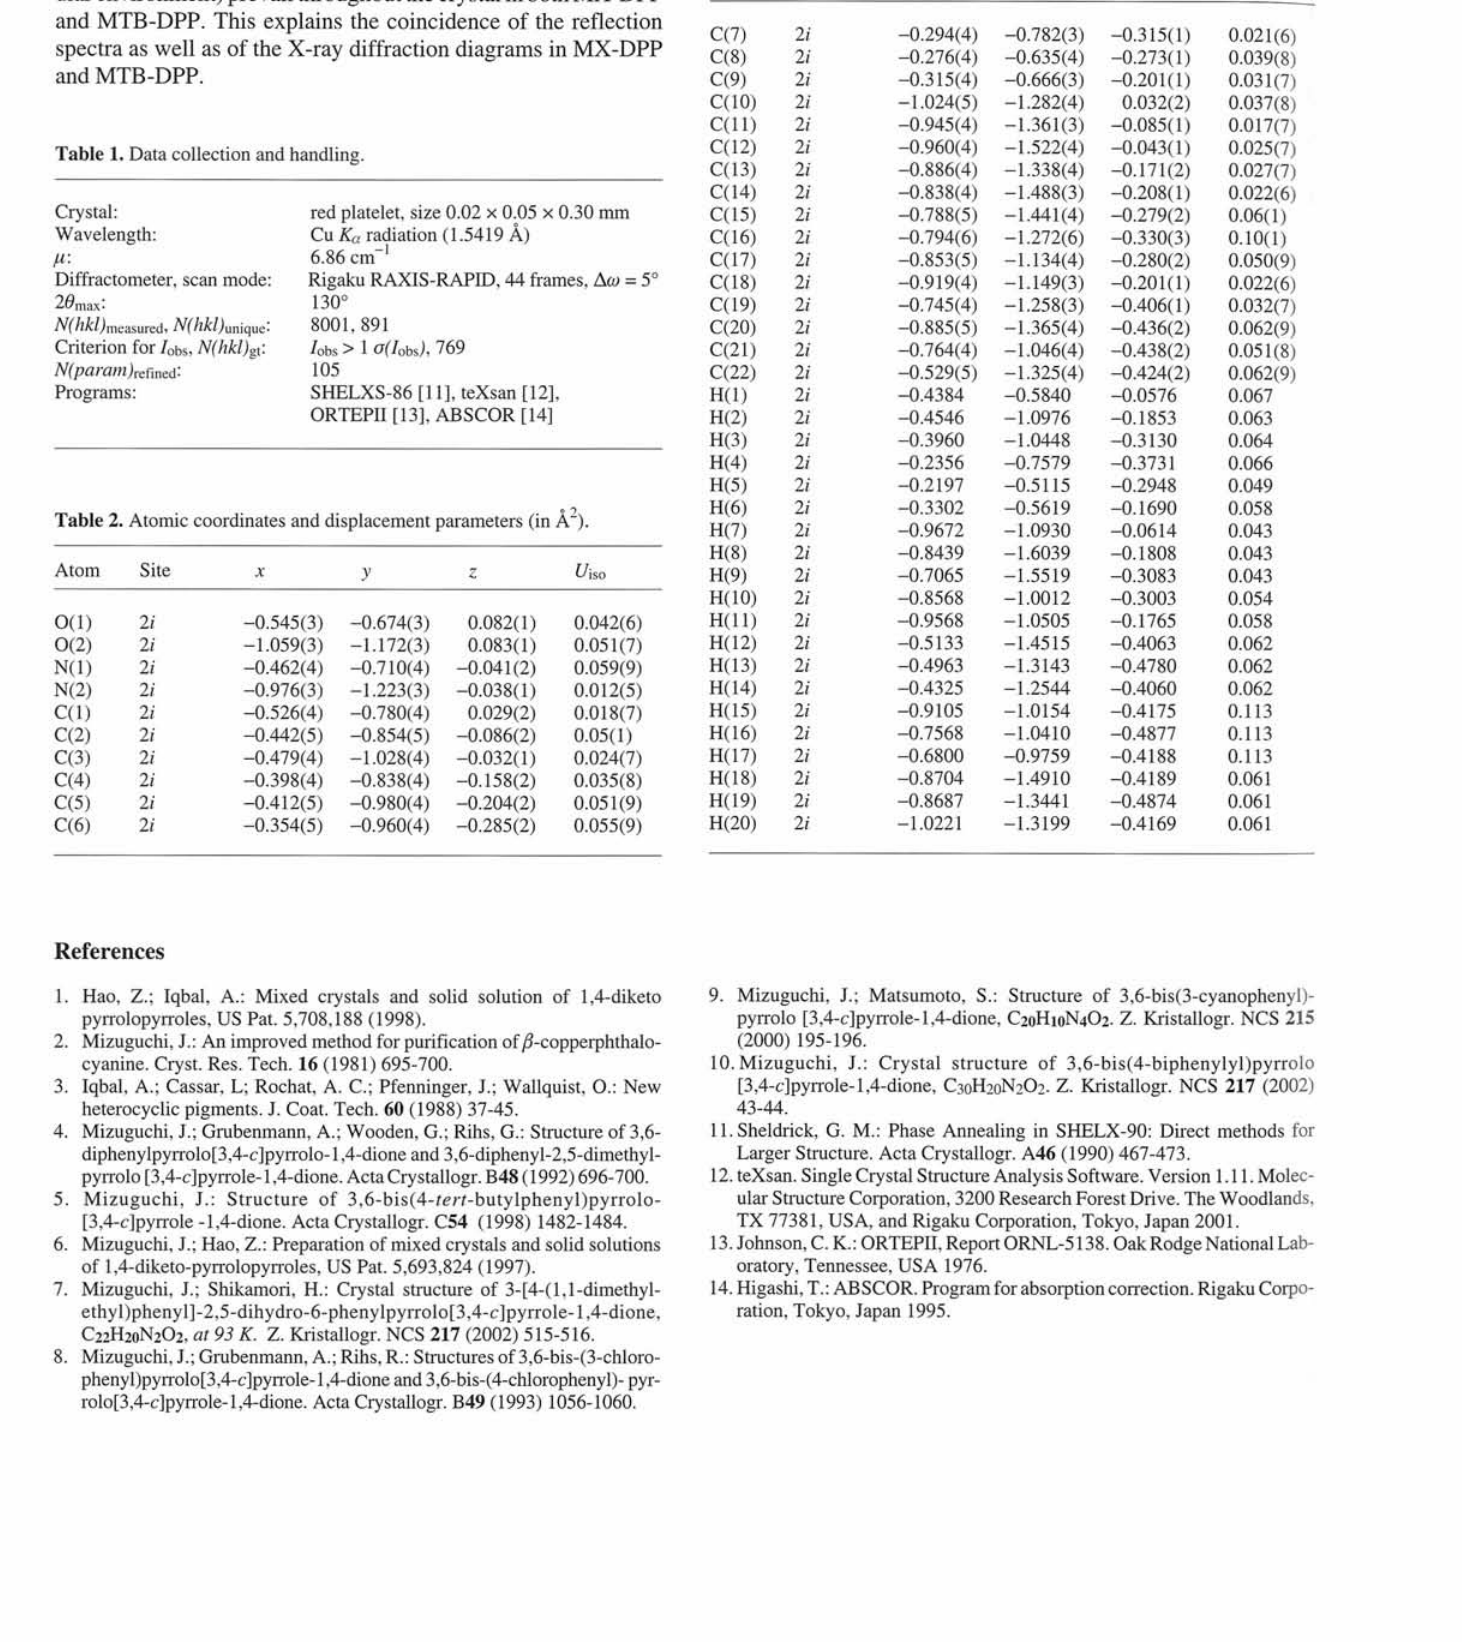
Table 2. Atomic coordinates and displacement parameters (in Â 2